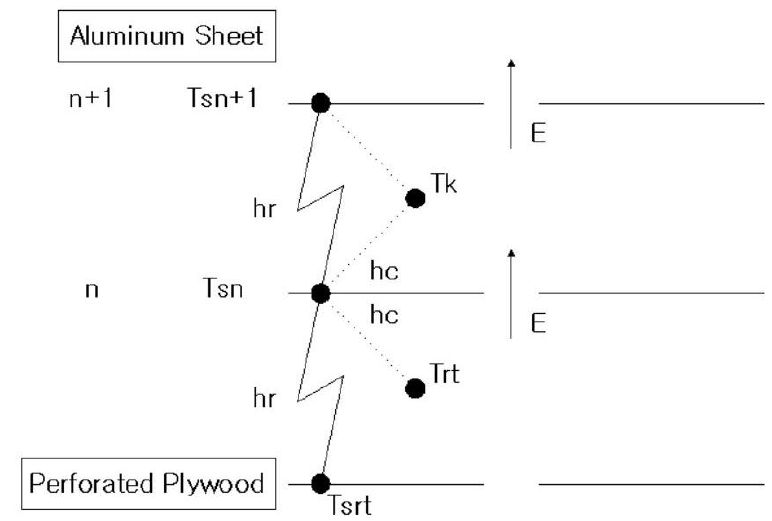
Figure 2. Schematic of the heat transfer numerical model.